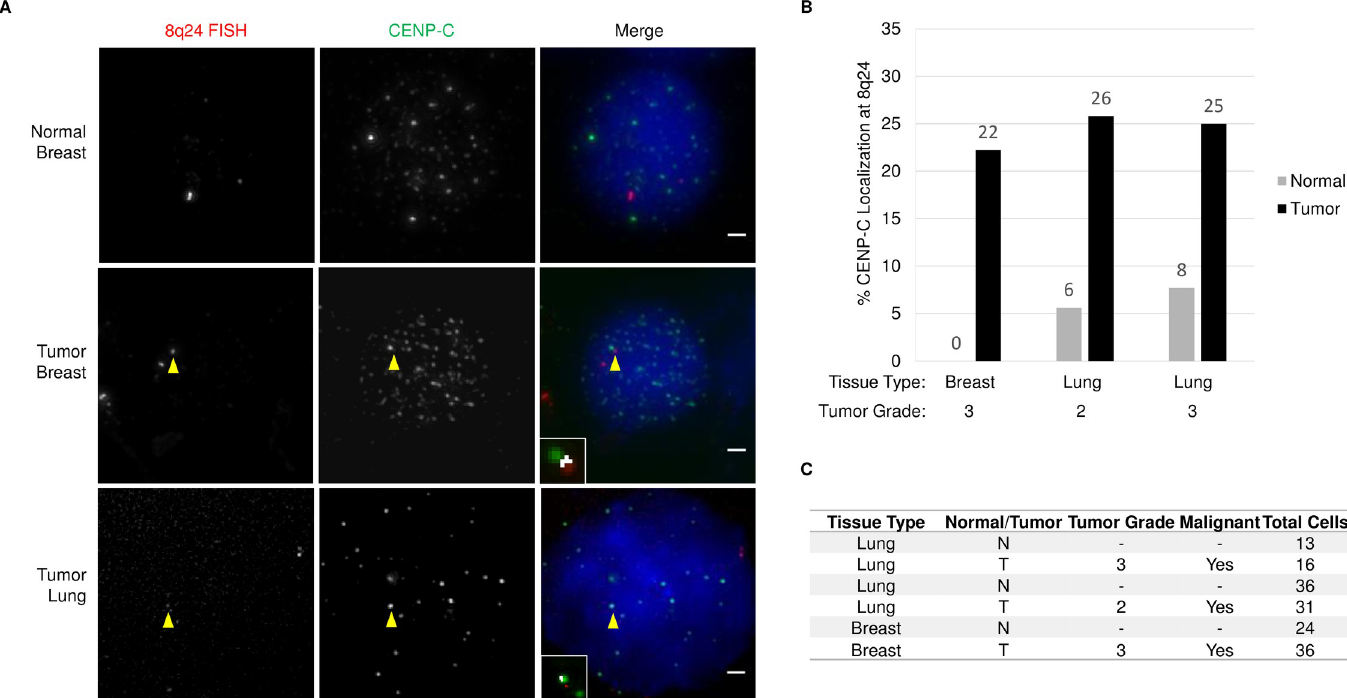
Fig 7. CENP-A localization to the 8q24 locus is common feature of cancer cells. A.) Images showing breast or lung cells isolated from normal or tumor tissue immunolabeled for CENP-C and FISH for 8q24. Yellow arrowheads indicate colocalization. Inset shows co-localization analysis performed using Image J; white is indicative of co-localization. Scale bar indicates 1 μ m. B.) Graph quantifying the number of cells with colocalization between CENP-C and 8q24. C.) Table indicating the tissue type and tumor grade or each specimen examined.